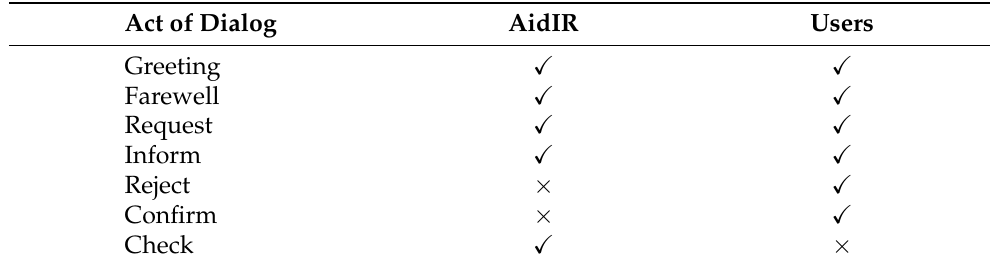
Table 3. Dialog act in